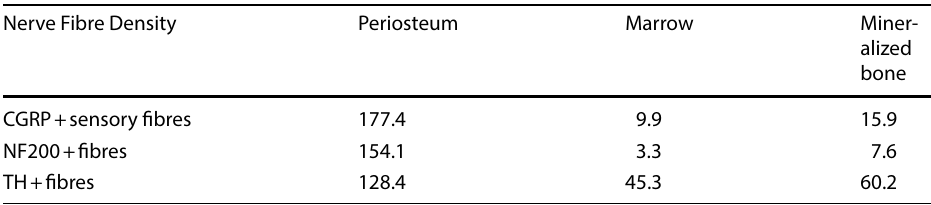
Table 1 Density of sensory and sympathetic nerve fibres in the distal femur of the mouse, normalized to tissue area (fibres per mm 2 ) in the three major bone compartments